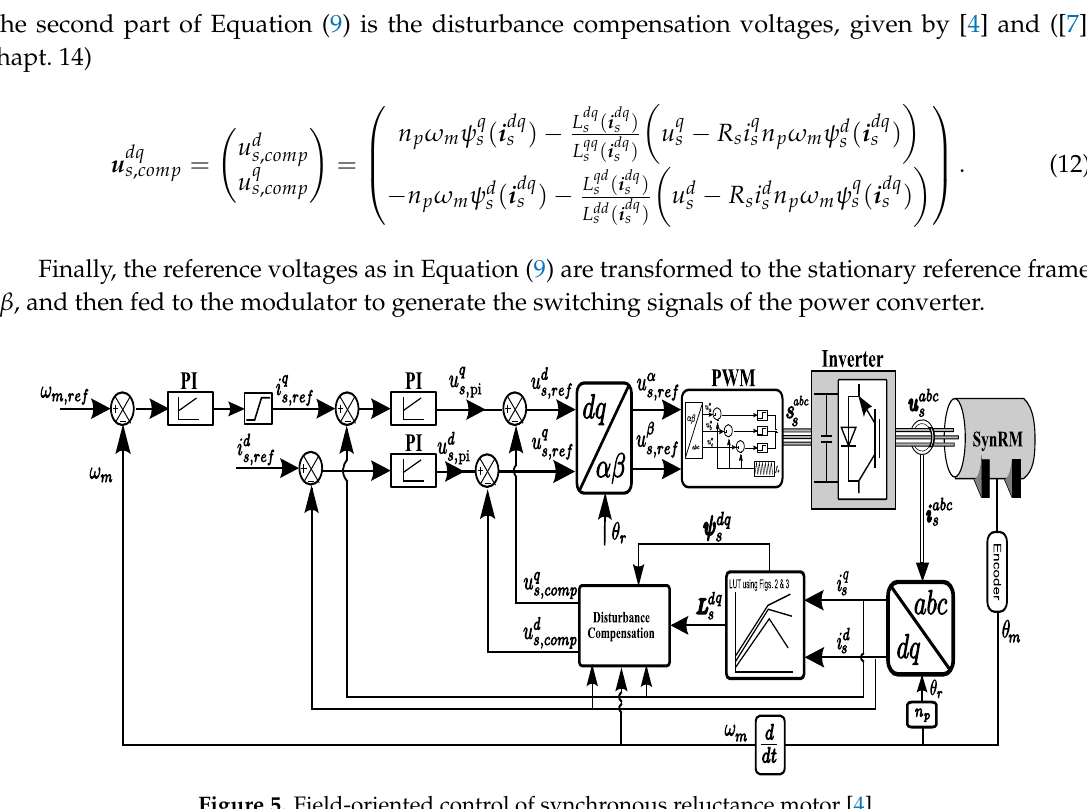
Figure 5. Field-oriented control of synchronous reluctance motor